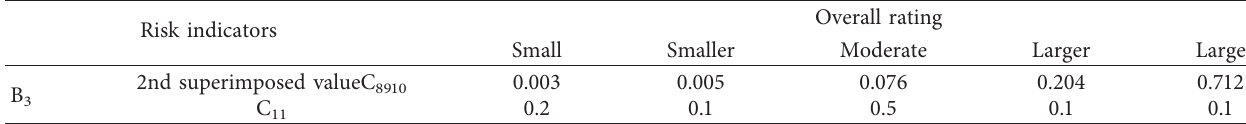
Table 7: Probability distribution of the 2nd superimposed parallel risk level.